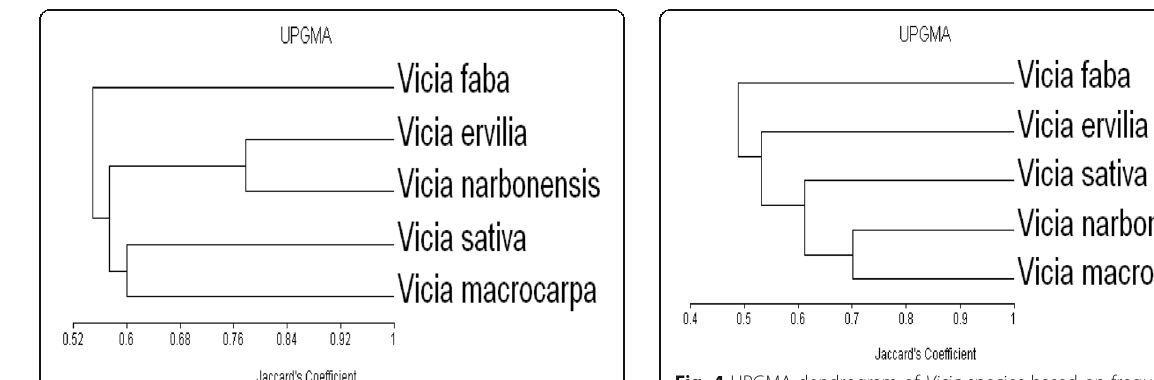
Fig. 4 UPGMA dendrogram of Vicia species based on frequencies of seed non-soluble